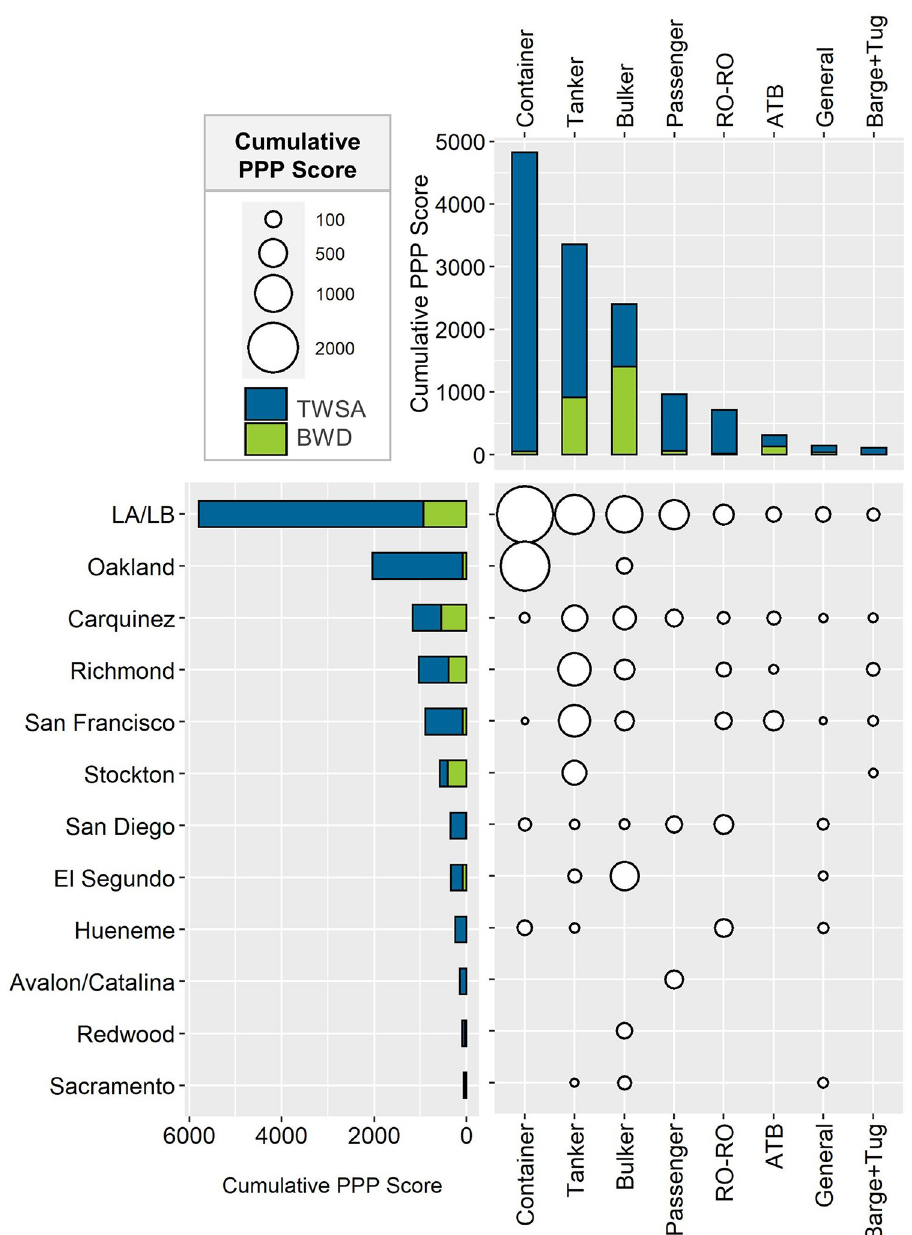
Fig 2. Cumulative PPP score observed in California during 2018. Bars represent the contribution of total wetted surface area (TWSA; blue) and ballast water discharge (BWD; green) to the combined cumulative score at all locations (horizontal) and all the different vessel types (vertical). Bubble size represents the cumulative score ranging from 2750.3 (largest bubble) to < 1 (smallest bubble). ATB refers to articulated tug-barge. Ports with less than 50 arrivals were removed from the figure (Alameda, Santa Barbara, Monterey, Humboldt and